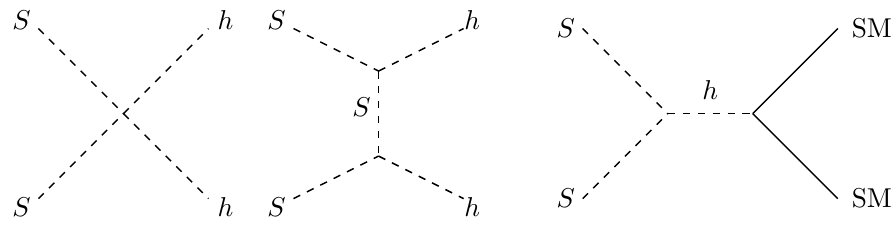
Figure 4 . Feynman diagrams for Scalar DM S annihilating to SM particles i.e S S